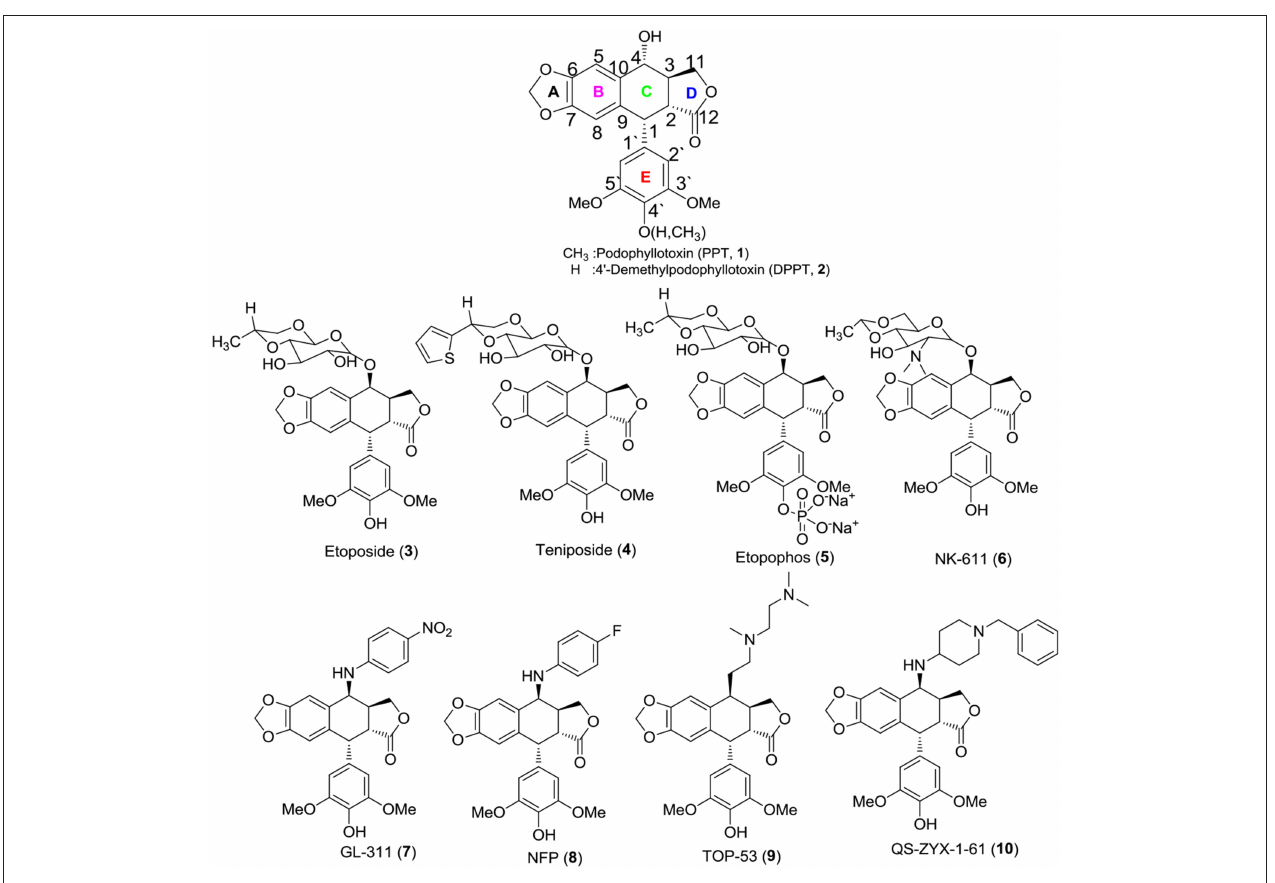
FIGURE 1 | Structures of PPT, DPPT, and related compounds.